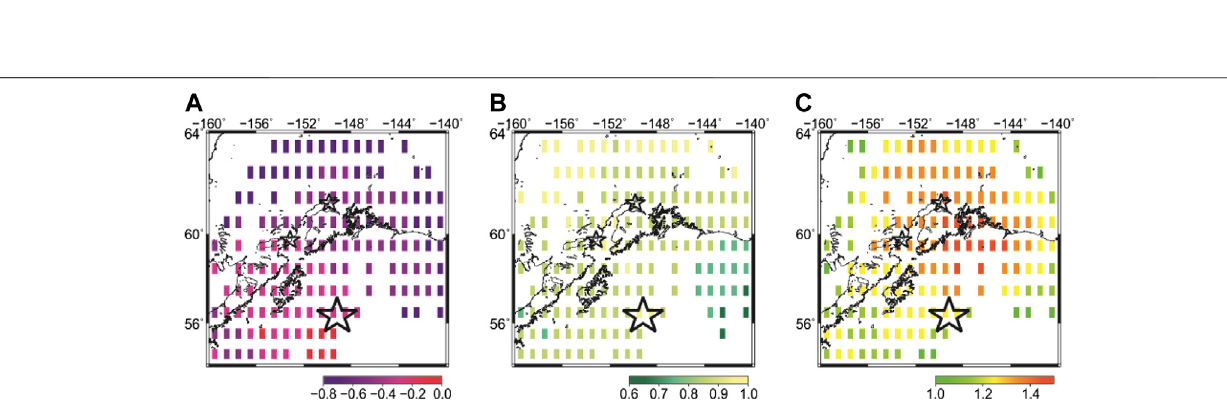
Frontiers in Earth Science |